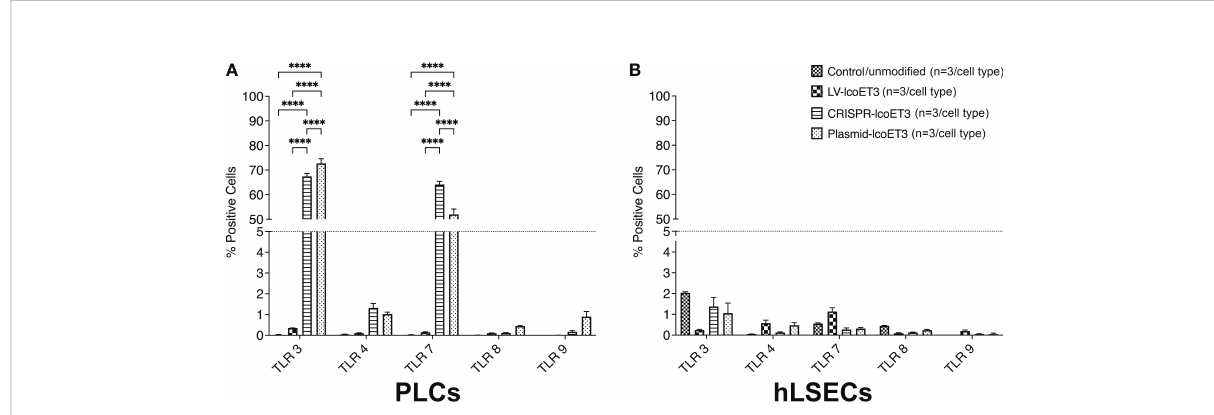
FIGURE 6 Flow cytometric analysis to quantify expression of Toll-like receptors (TLRs) on unmodi fi ed and gene-modi fi ed PLCs (A) and hLSECs (B) . n = 3/ experimental group for each cell type. ****p<0.0001.